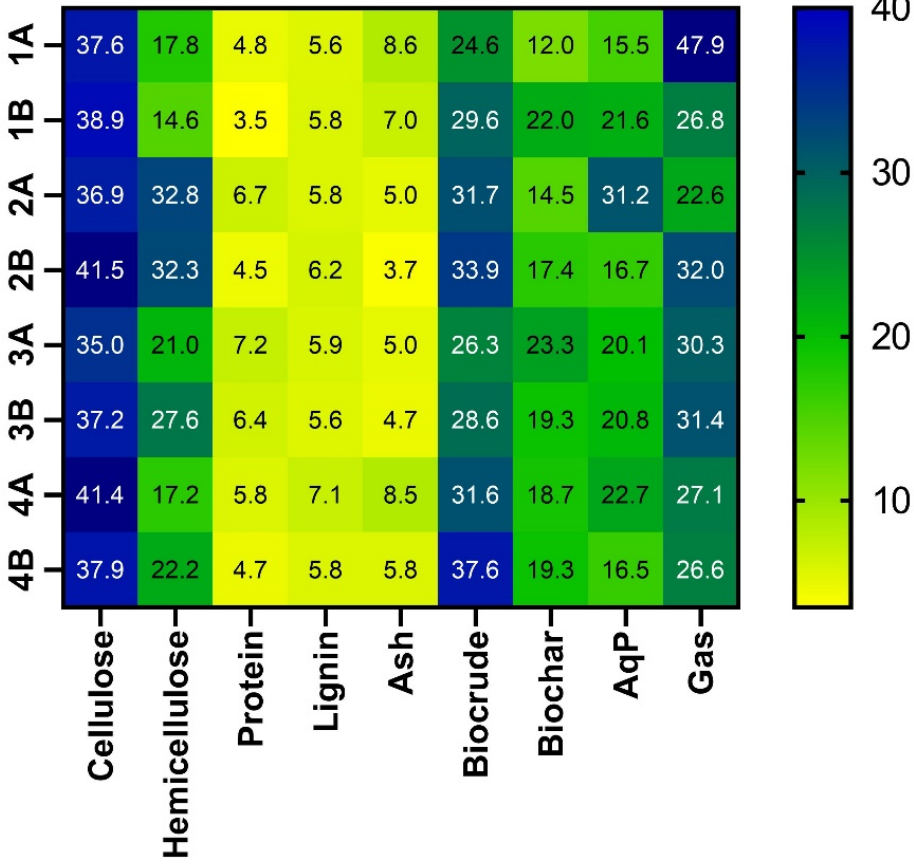
Figure 1. Heat map comparing feed composition and HTL fractions yields. The values in each square are the mean content of each parameter named in the columns. The content is reported in mass fraction (%). In the rows, the numbers refer to each plant species named: 1, Iris pseudacorus ; 2, Juncus effusus ; 3, Phragmites australis ; and 4, Typha latifolia . The letters A and B refer to the growing environments: A = TW, and B = NC environment.